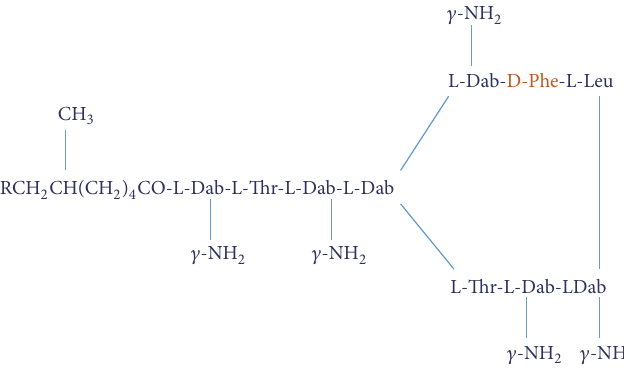
Figure 1: Structure of polymyxin